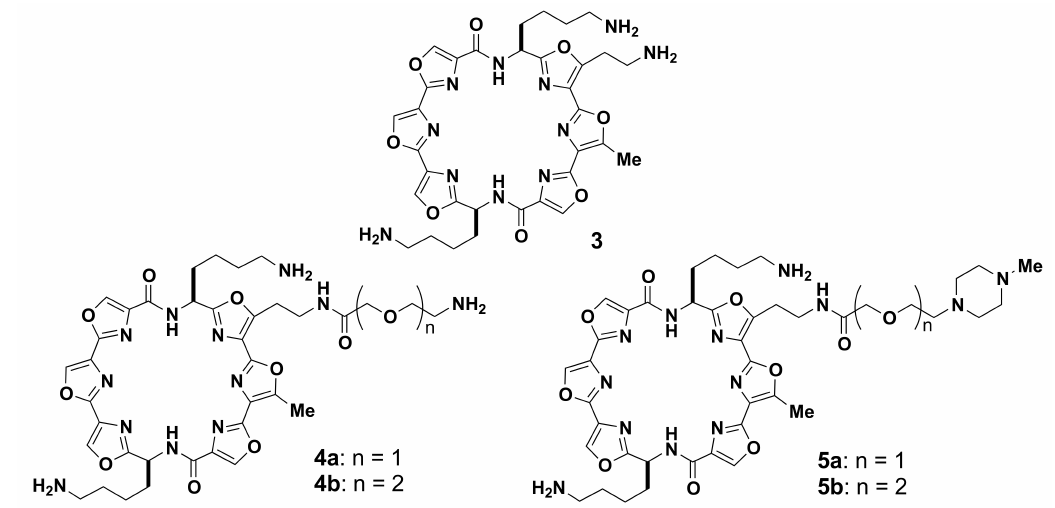
Figure 2. Structures of novel 6OTD analogs 3 – 5 targeting the G-quartet and the groove of telomeric